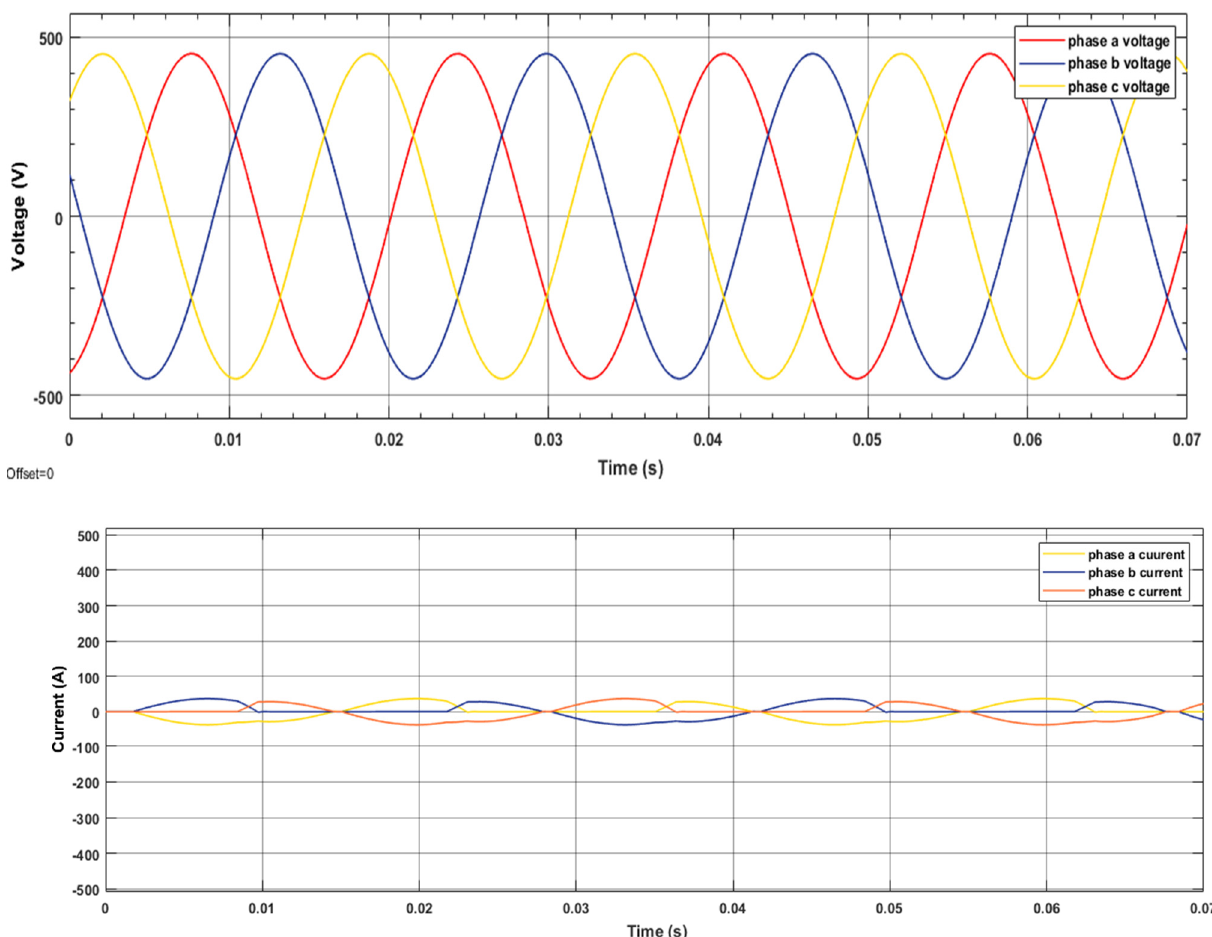
Figure 13. Phase to phase voltage and current for condition without PEMFC.